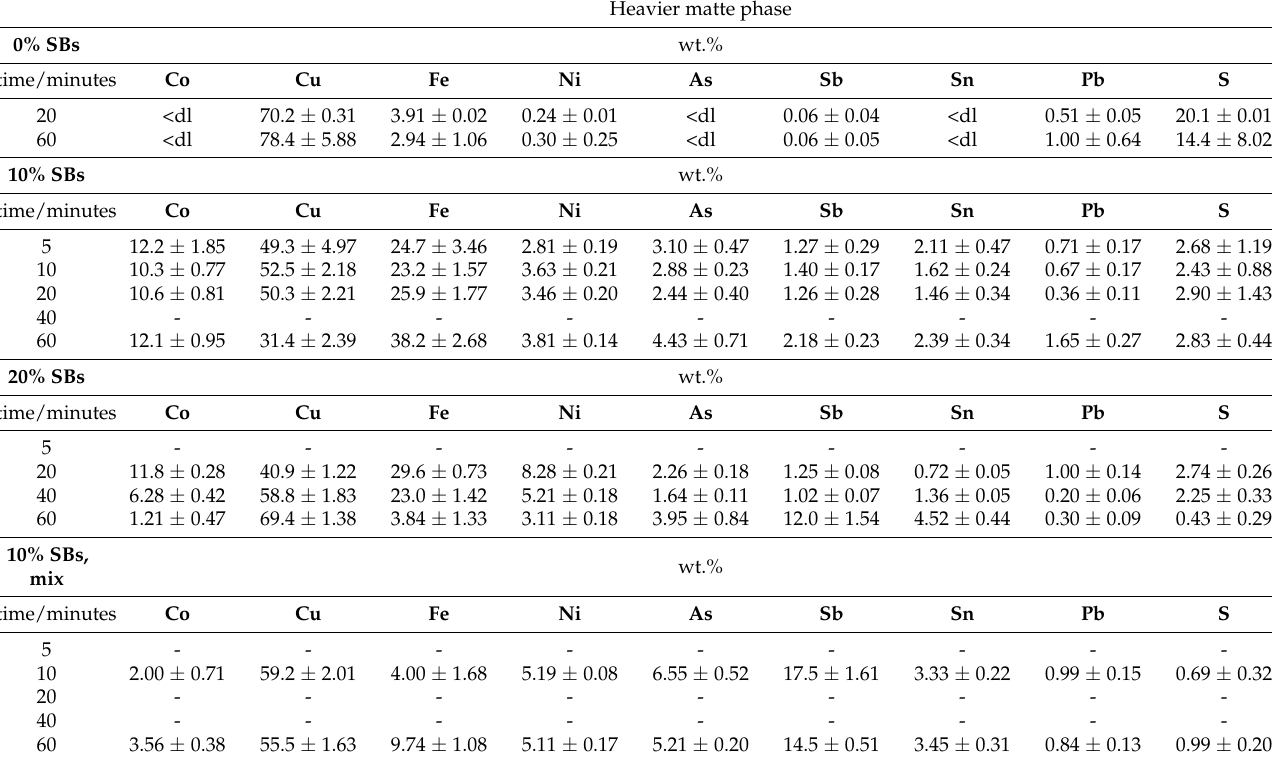
Table A3. Chemical composition of heavier matte phase analyzed with